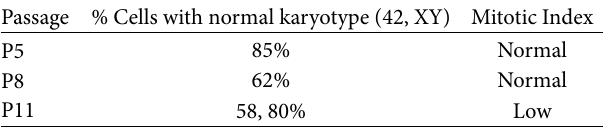
Table 3: Percentage of normal karyotypes and mitotic indexes of OM-MSCs in P5, P8, and